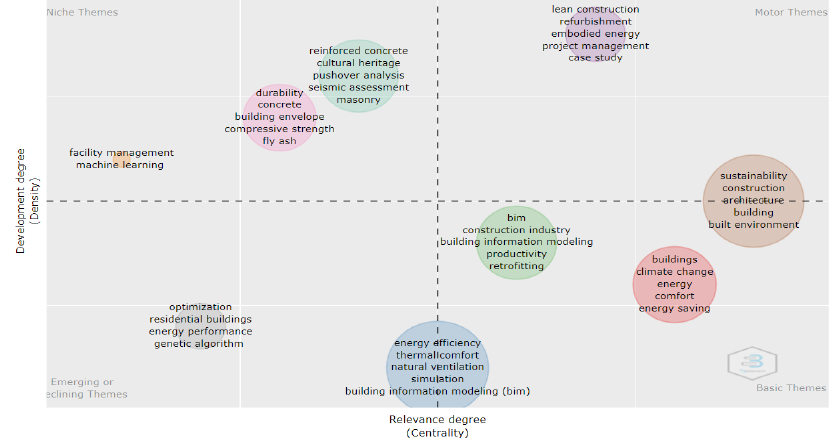
Figure 4. Thematic map of keywords.